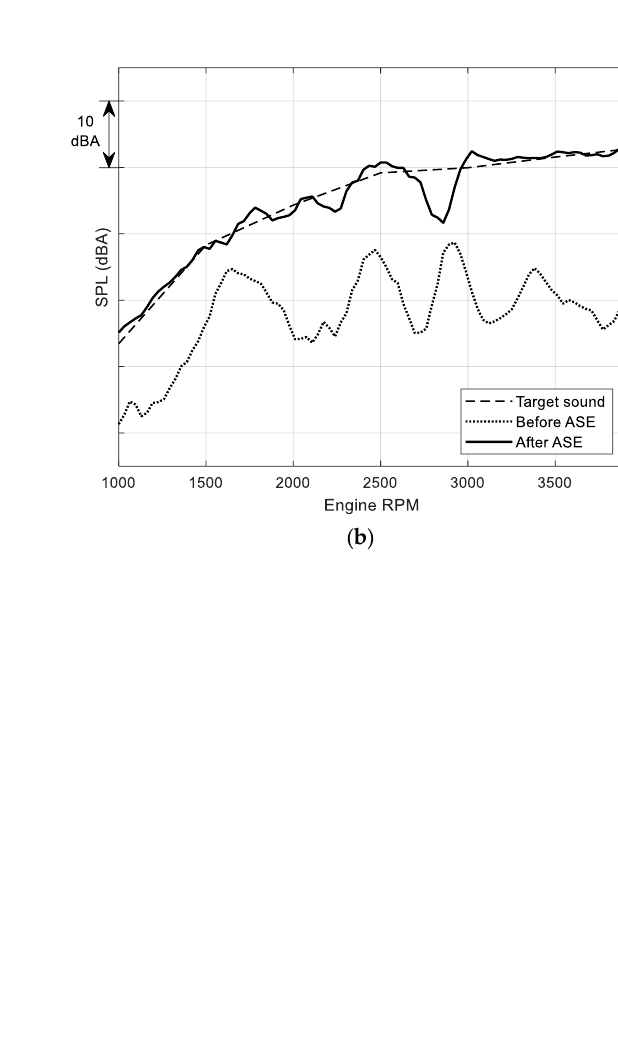
Figure 13. Comparisons of the SPLs of the measured engine sound before (dotted lines) and after (solid lines) ASE with the target sounds (dashed lines). ( a ) C3 order. ( b ) C5 order. ( c ) C6 order.